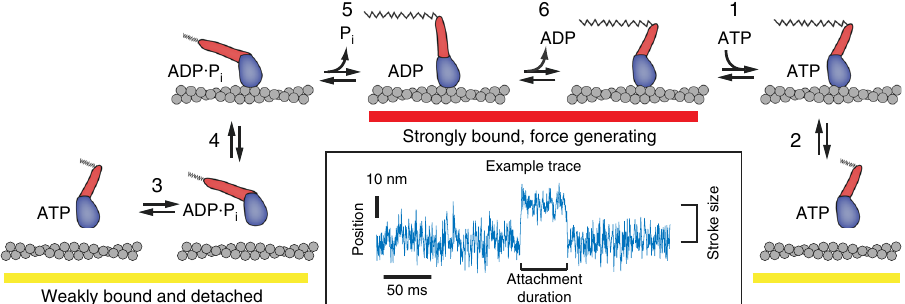
Fig. 1 Biochemical cycle of cardiac myosin. Omecamtiv mecarbil has been shown to increase the rate of phosphate release (step 5) and bias the ATP hydrolysis step (step 3) towards the post-hydrolysis M·ADP·P i state, which is proposed to cause myosin to enter the strong binding states (red underline) more rapidly. Other biochemical steps have been previously shown through stop- fl ow biochemical experiments to be nearly unchanged by the presence of OM. Inset: Example optical trapping trace of the position (median fi ltered with 0.4 ms window) of an actin fi lament during one interaction with a single- myosin molecule reproduced from Fig. 2b. The step size and attachment duration of these interactions can be measured